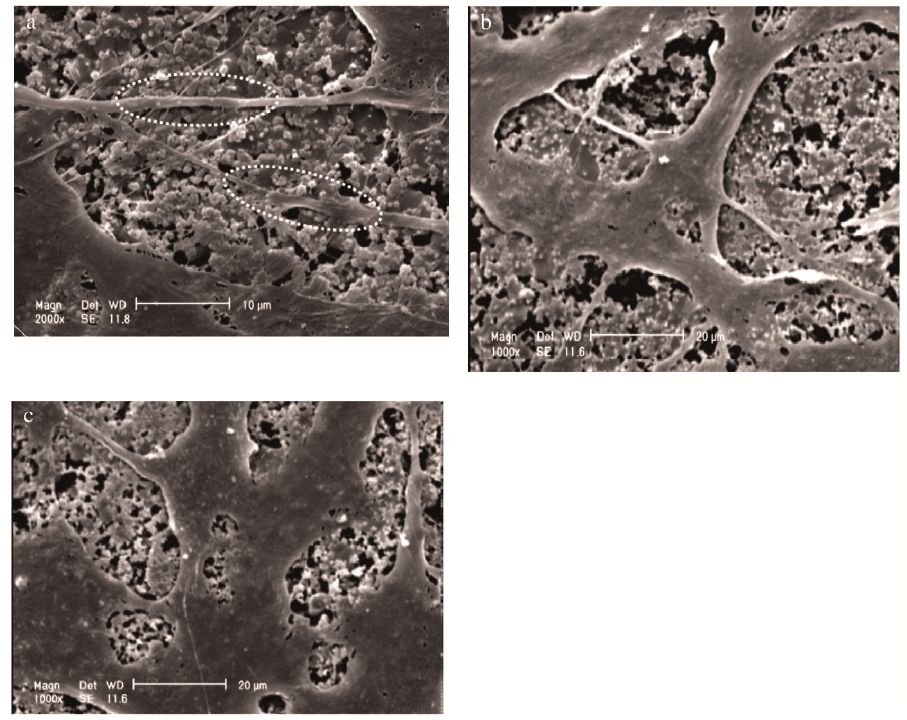
Figure 1. Bone cells show enhanced spreading and extension of filopodium (white dotted ovals) when cultured on nanostructured surfaces. SEM (scanning electron microscopy) images of ROS17/2.8 cells grown on nanostructured HA/TiO ( c ) 9 days. Note the increased cell spreading over time with filopodial extension. Reprinted from [35] with permission from Elsevier, Copyright